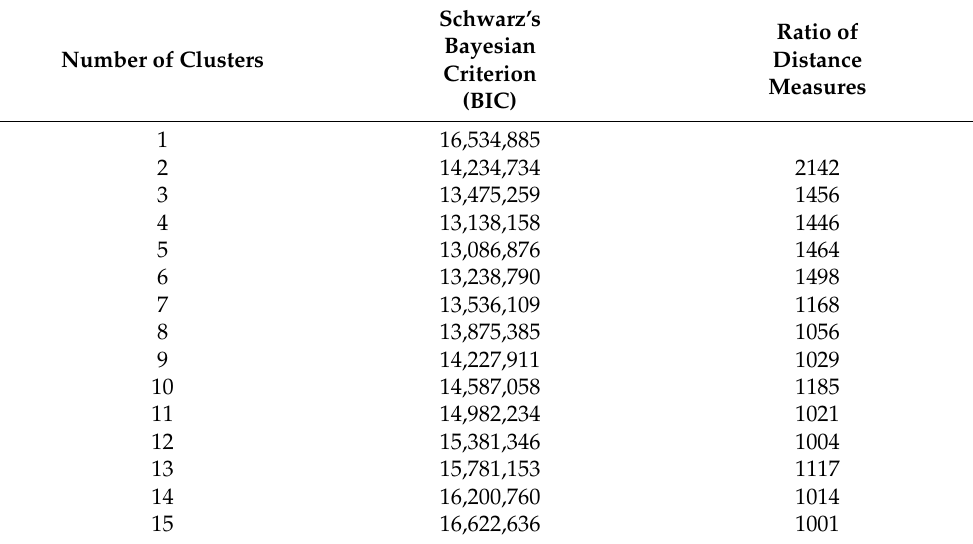
Table 2. Auto-clustering.